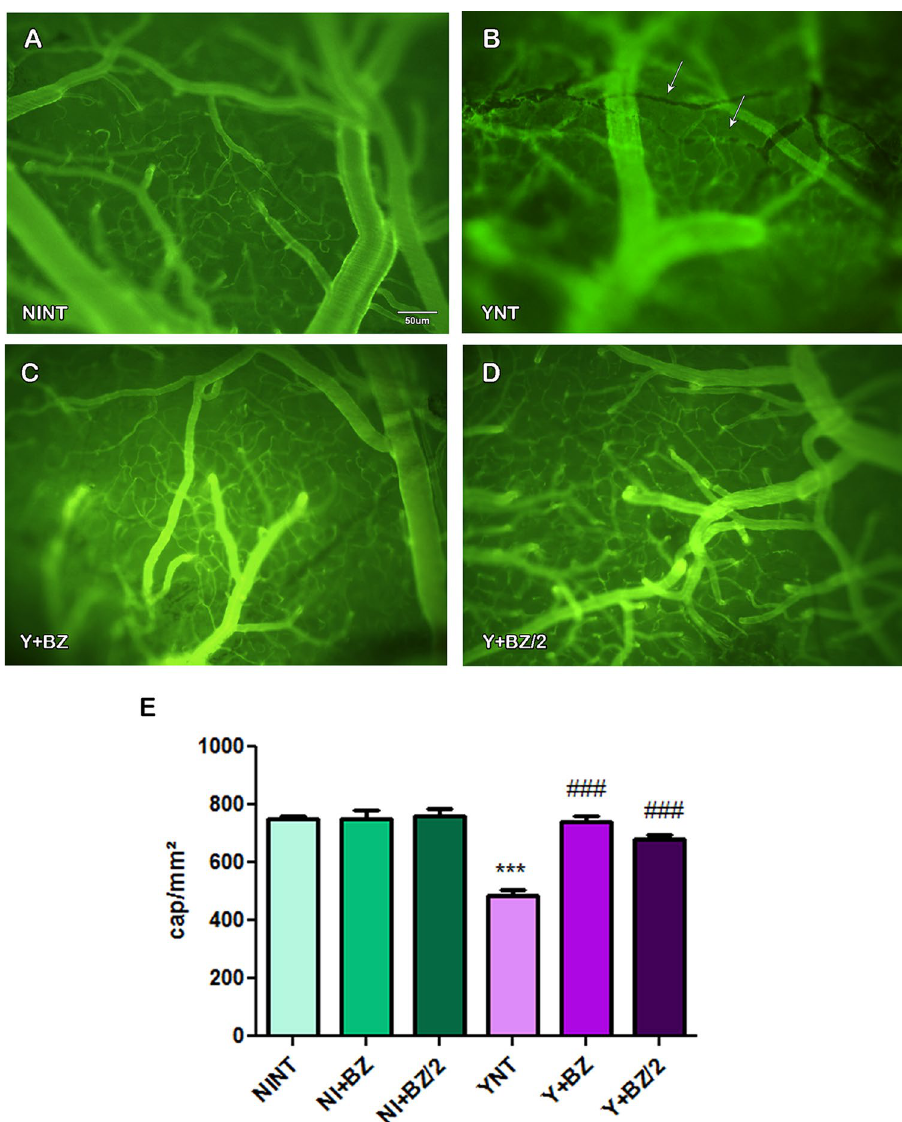
Figure 2. Capillaries functional density analysis by intravital microscopy in mice’s brain at 15 dpi. YNT group ( B ) had decreased number of capillaries in when compared to NINT group ( A ). Benznidazole treatment schemes prevented this decrease ( C , D ). Graphic indicate the number of spontaneously perfused capillaries ( E ). Arrows indicate non perfused capillaries. NT, non treated; BZ, treated with benznidazole (100 mg/kg/day); BZ/2, treated with benznidazole (50 mg/kg/day); dpi, days post-infection. *when compared to NINT; #when compared to YNT; *p < 0.05, **p < 0.01; ***p <